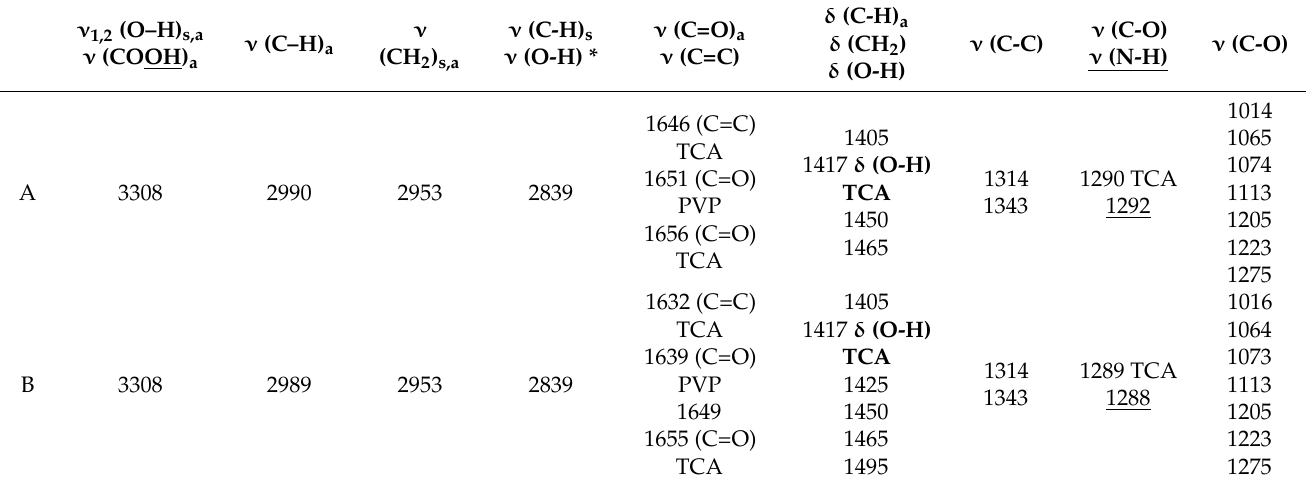
Table 3. FTIR analysis [cm –1 ] of AV-PVP-TCA (A) and AV-PVP-TCA-I 2